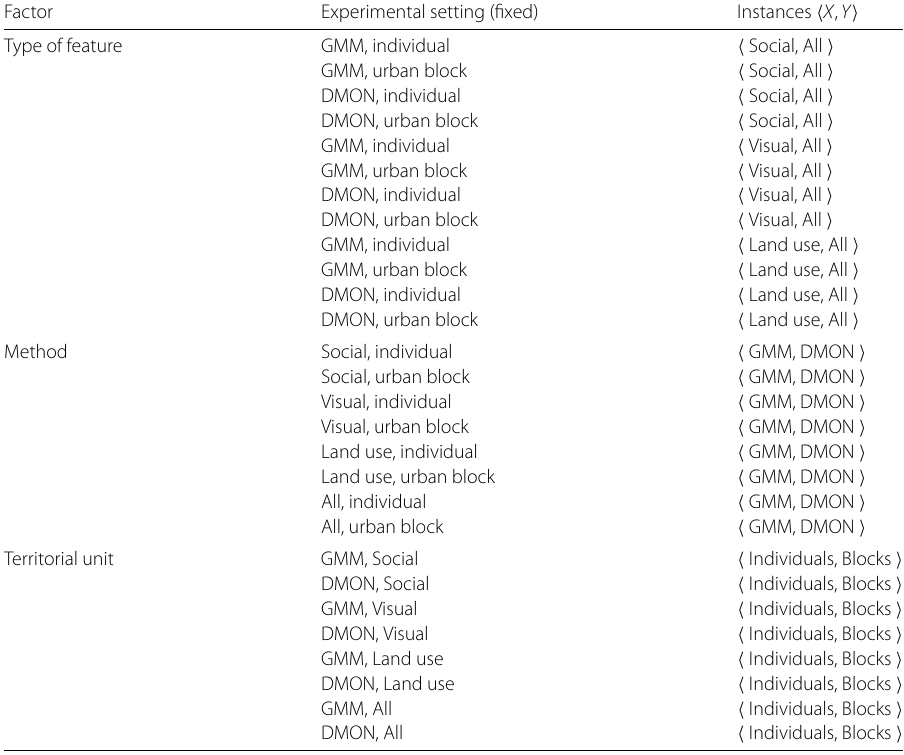
Table 2 Paired tests used in the survey ∗